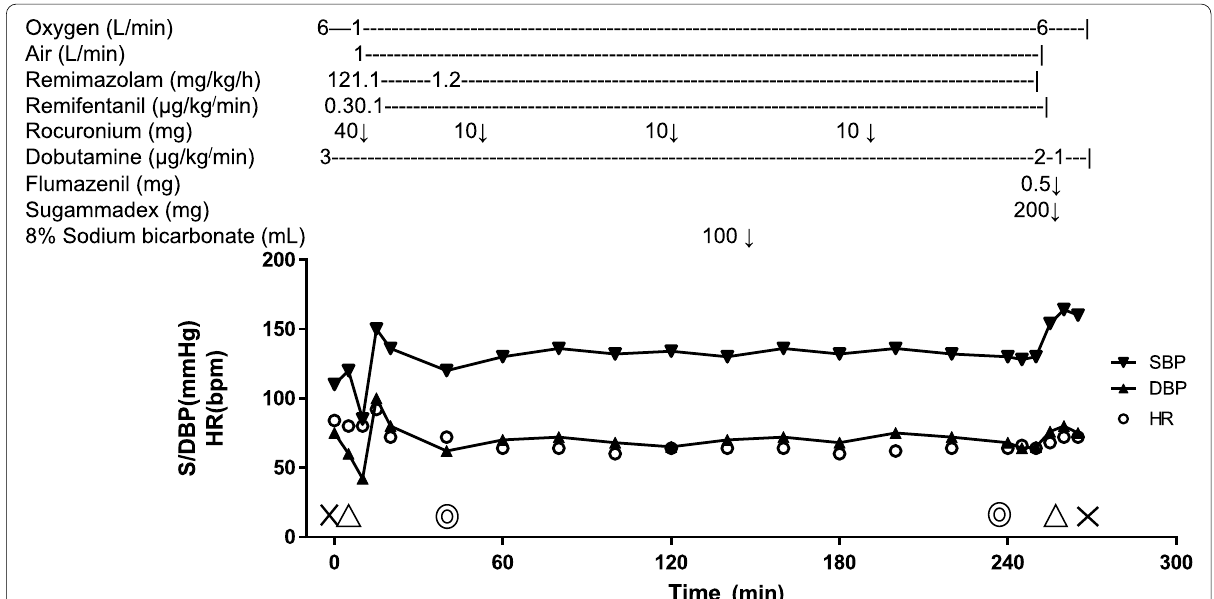
Fig. 1 The anesthesia chart. Blood pressure and heart rate were maintained with dobutamine 3 µg/kg/min, which was started preoperatively. SBP: systolic blood pressure, DBP: diastolic blood pressure, HR: heart rate. X: start and end of anesthesia, ∆: tracheal intubation and extubation, double circle: start and end of